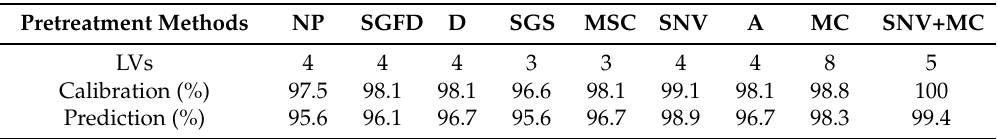
Table 1. Comparison of the different preprocessing methods based on partial least squares discrimination analysis (PLSDA) models.